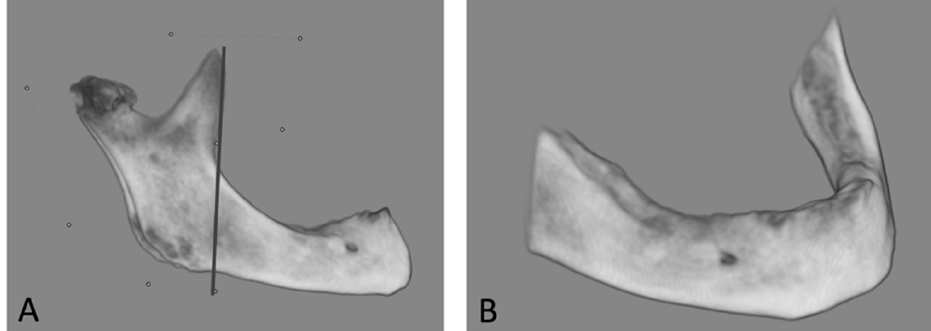
Figure 3. Measurements of the mandibular bone volume with Dolphin Imaging Plus TM . ( A ) The mandible was separated from the surrounding structures. A line perpendicular to the border of the mandible was drawn along the front of the coronoid process. ( B ) The total size (volume) of the mandible in front of the line was measured.